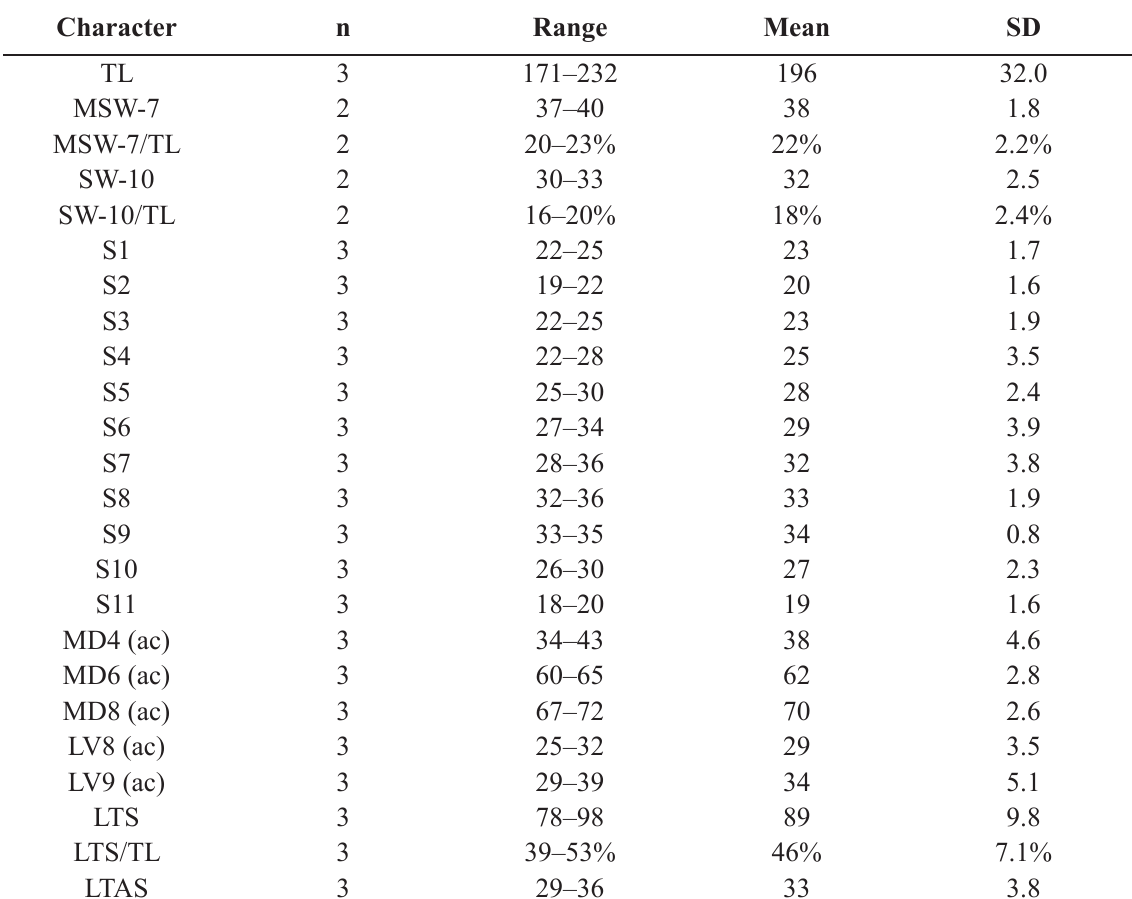
Table 18. Measurements from light microscopy of Echinoderes aragorni sp. nov . (in µm) from the Hikurangi Margin, including number of measured specimens (n) and standard deviation